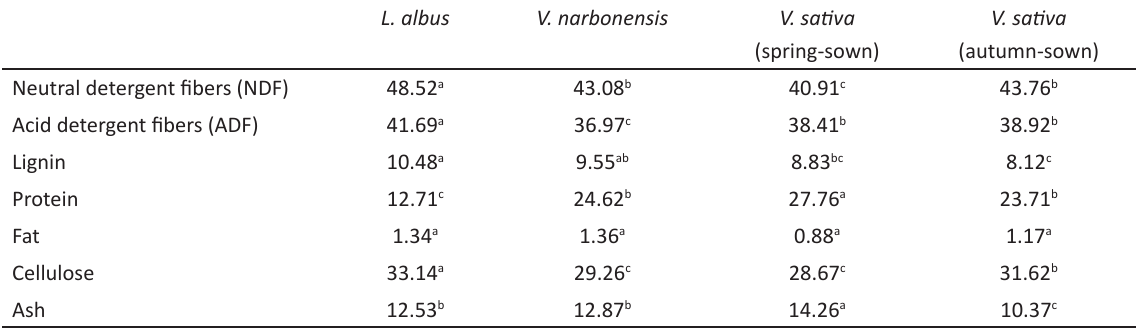
Table 4. Chemical composition of the forage dry matter (DM %) of aboveground plant biomass L. albus V. narbonensis V. sativa V. sativa